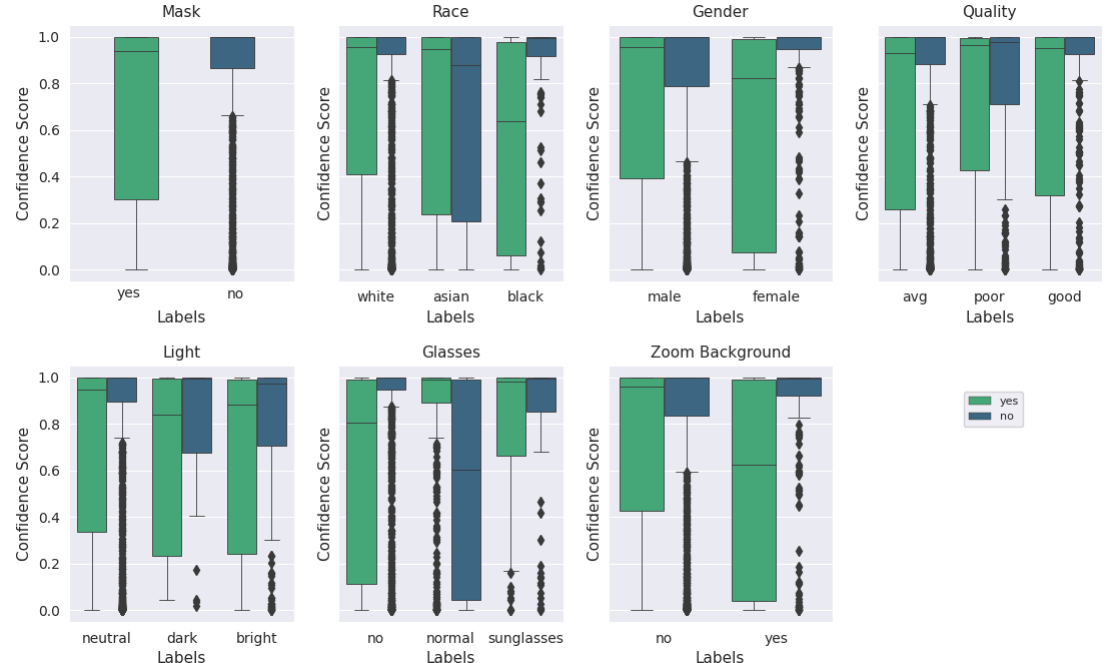
Figure A1. Box plot of categorical labels vs. confidence scores for all image qualities, as qualitatively evaluated, using the augmented MobileNetv2 model. For each category and its labels, ‘mask’ and ‘no mask’ scores are plotted beside each other. The median is represented by the center line of each box while the upper and lower bounds represent the respective quartiles. Outliers are represented by diamond